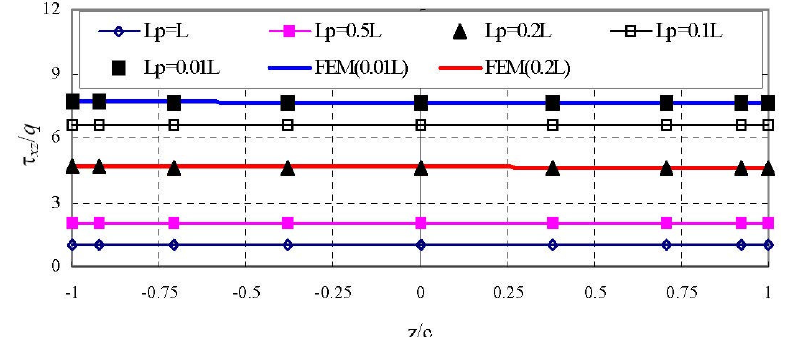
q ) of sandwich panels at x = − 0.0464 L. xz